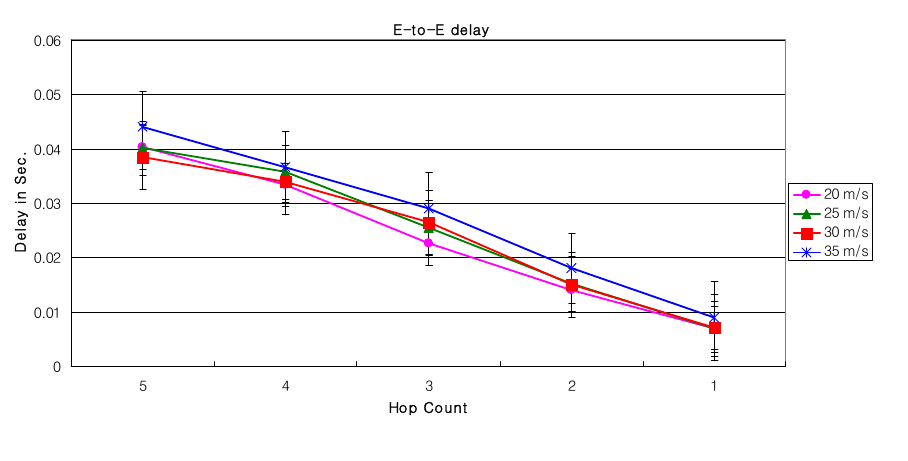
Figure 18. Delay vs. number of hops with variable MN’s speed (DLoWMob).